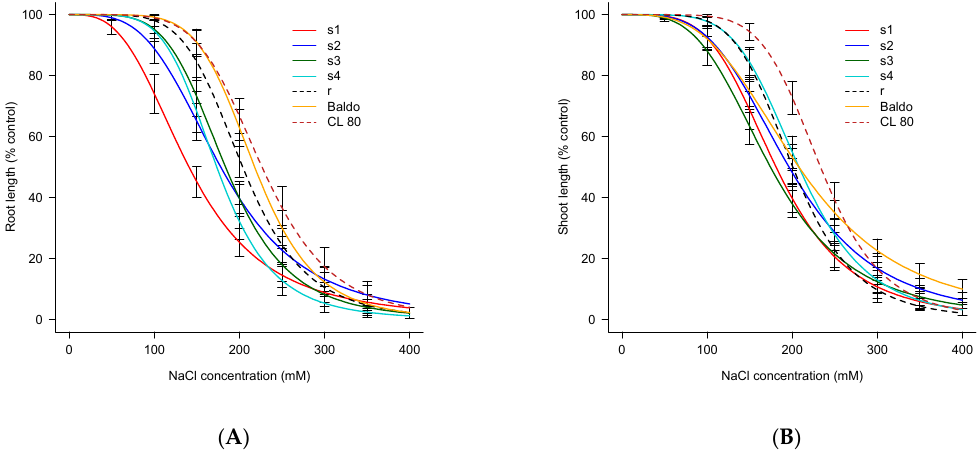
Figure 1. Root length ( A ) and shoot length ( B ) of the weedy rice populations and the rice varieties at the different NaCl concentrations as percentage relative to control (0 mM NaCl concentration).